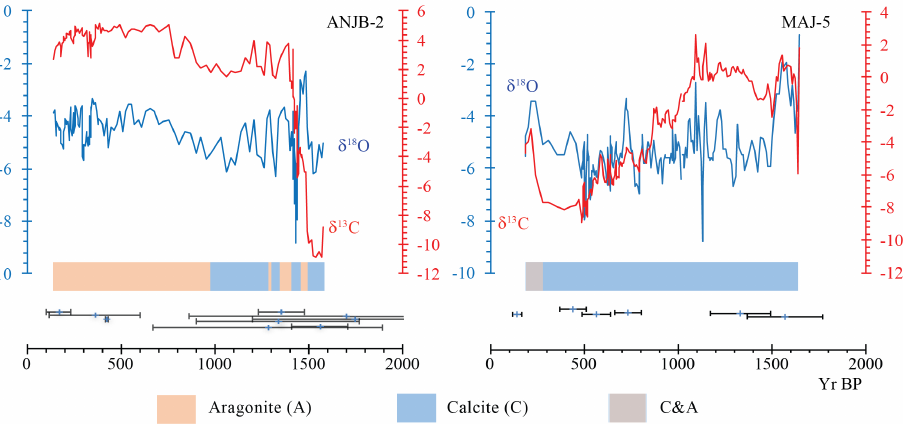
Figure 6. Variations in δ 13 C, δ 18 O, and mineralogy in Stalagmite ANJB-2 and Stalagmite MAJ-5 during the Malagasy late Holocene interval. Supplementary Fig. S7 shows both the corrected and uncorrected isotope values, and Fig. S8 compares the corrected δ 18 O values for both